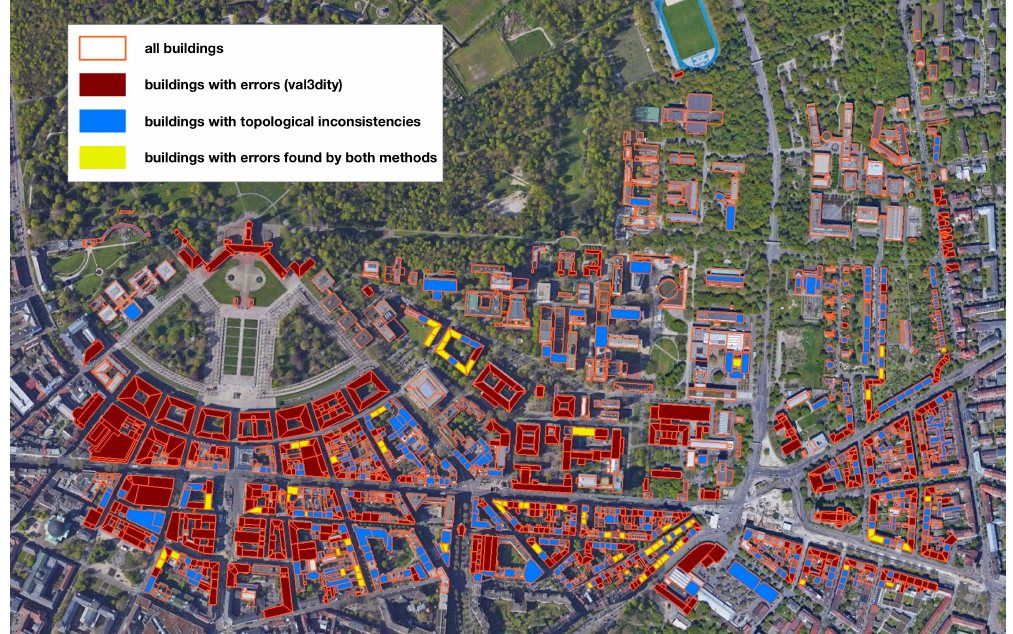
Figure 8. Building layout of the “Karlsruhe KIT/CS” data set with topologically inconsistent buildings found by both methods. Background layer: c (cid:13) 2019 Google, CityGML data: c (cid:13) City of Karlsruhe, Liegenschaftsamt,